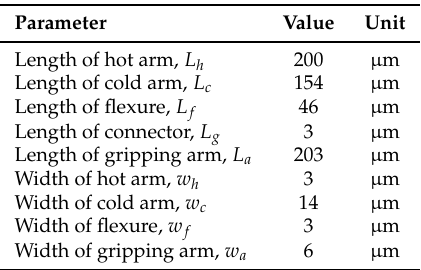
Table 1. Fixed geometrical dimensions of the studied microgripper design variants. The dimension annotations are given in Figure